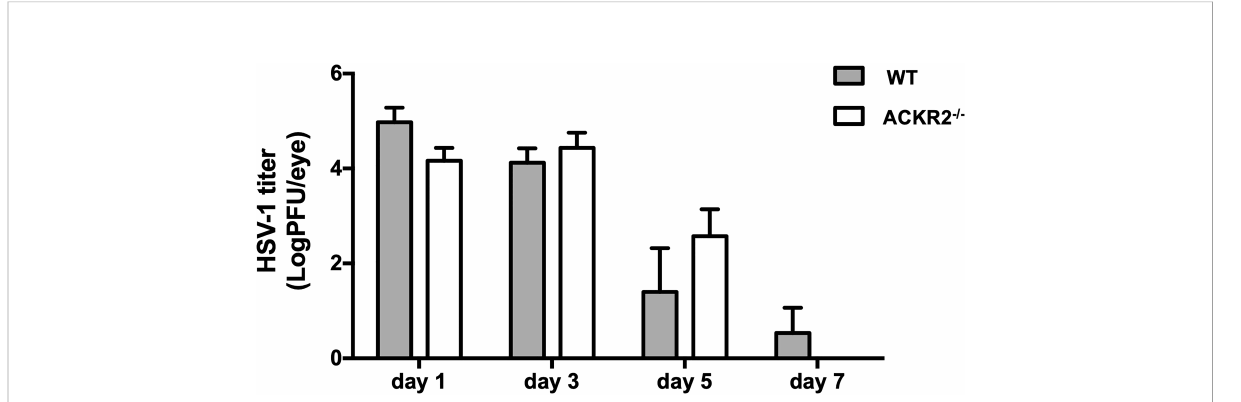
FIGURE 3 HSV-1 viral burden in corneal tear fi lms of infected mice is similar in ACKR2 -/- and WT mice. ACKR2 -/- (clear bar) and WT ( fi lled bar) mice were infected with 5.4 x 10 5 pfu of HSV-1 virus on scari fi ed corneas. Corneal swabs of tear fi lm samples from infected corneas were harvested and snap frozen at day 1, day 3, day 5 and day 7 p.i. and stored in DMEM at -80°C until use. Standard plaque assay was then performed with tear fi lm samples with each dilution plated in triplicates and viral load was calculated for each individual mouse. N = 5. Statistical analysis was performed with unpaired student ’ s t test. Data are representative of two independent experiments and shown as mean ± SEM.